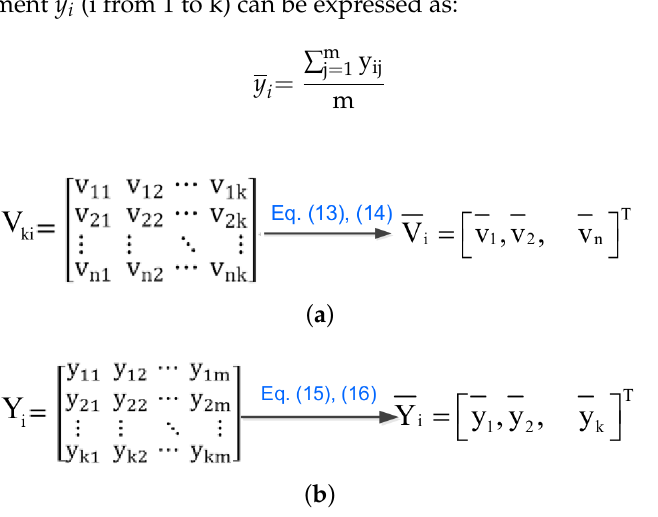
Figure 4. The overall block diagram of error confinement technique based on PCA. ( a ) Generating a column average vector Y i of Y i , ( b ) Generating a column average vector Y i of Y i